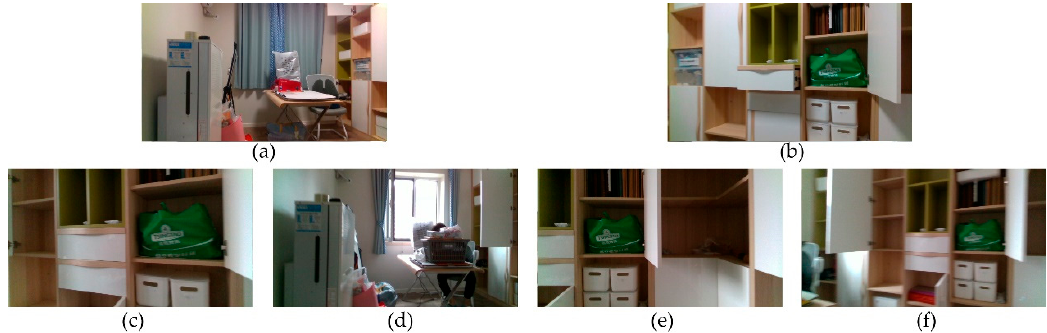
Figure 4. Query images in home scene and query results; ( a ) Query image no. 1; ( b ) query image no. 2; ( c ) query result of image 1 with the VLAD method; ( d ) query result of image 1 with our proposed method; ( e ) query result of image 2 with the VLAD method; ( f ) query result of image 2 with our proposed method.